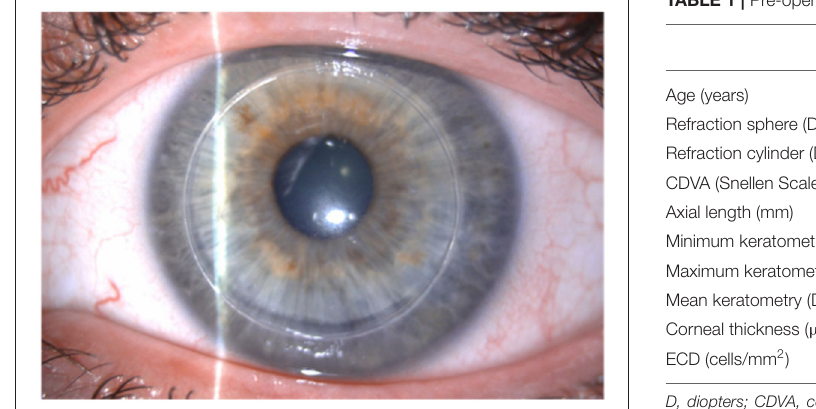
FIGURE 2 | Neoring 24-months post-operatively.